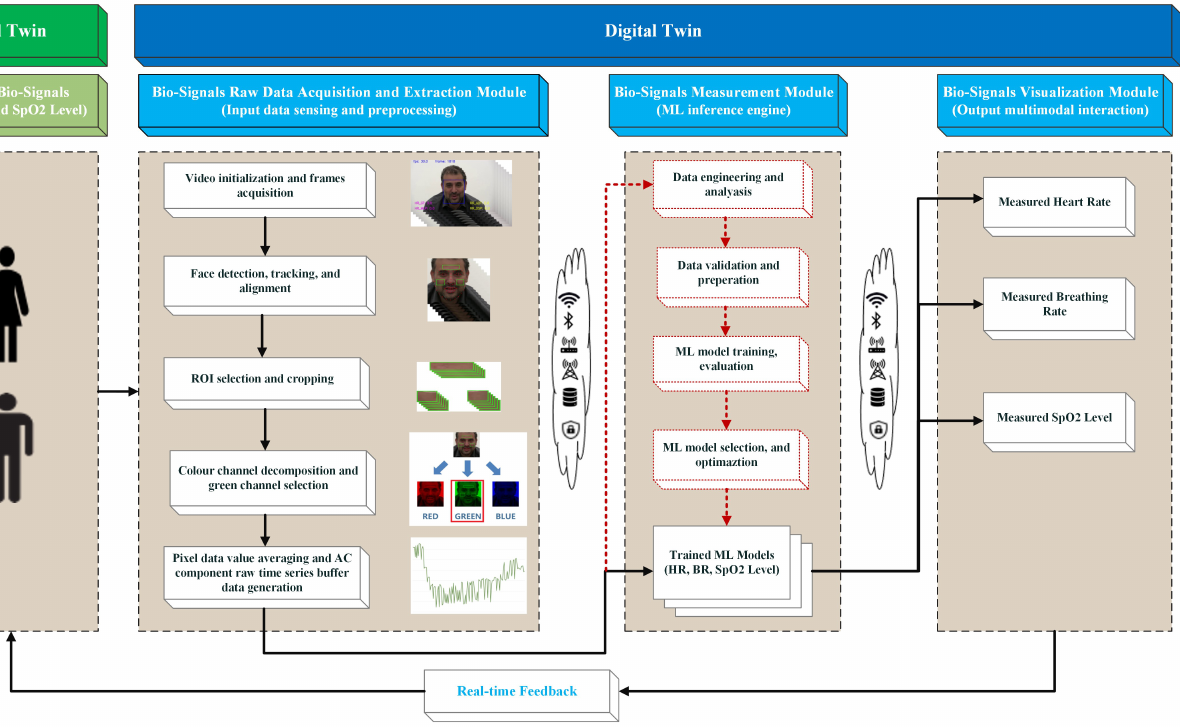
Figure 1. System Architecture of the Machine Learning-based Digital Twin for Non-Invasive Human Bio-Signal